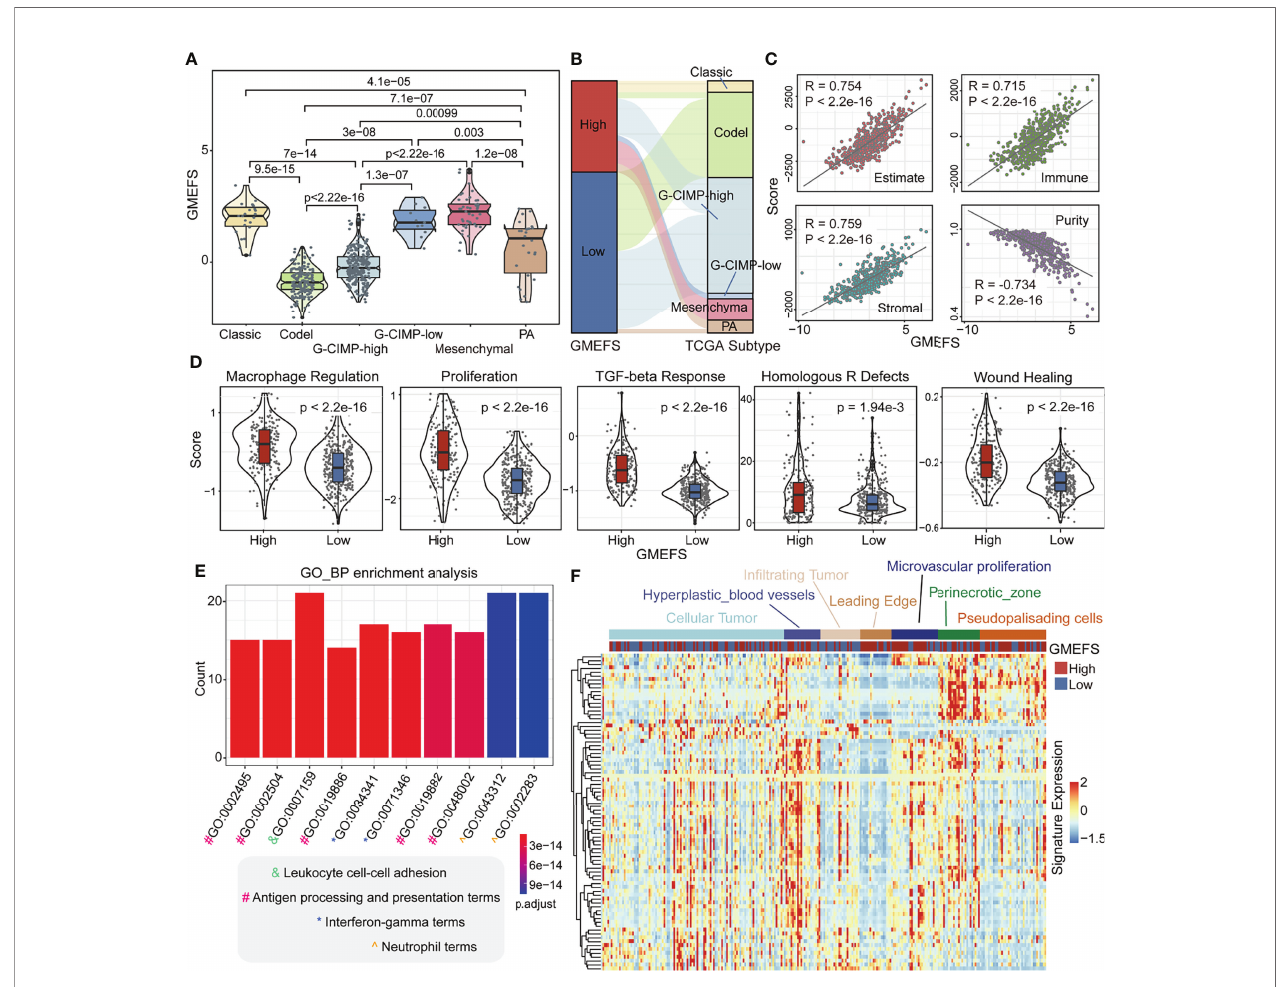
FIGURE 3 | Clinical signi fi cance and functional analysis of the two GMEFS groups in TCGA-LGG. (A) Violin plot illustrating the distribution of the GMEFS score in different intrinsic molecular subtypes. (B) Sankey plot of the GMEFS values in subtypes with different intrinsic molecular subtypes. (C) Correlations between the GMEFS score, stromal score, immune score, ESTIMATE score, and tumor purity. (D) Comparison of Macrophage Regulation, Proliferation, TGF-beta Response, Homologous R Defects, Wound Heal between the high and low GMEFS groups. TCGA-LGG patients were classi fi ed into low and high GMEFS groups. Visualization of the top 10 enriched biological processes (E) by the upregulated differentially expressed genes (DEGs) in the high vs. low GMEFS groups. (F) Heatmap of the upregulated DEGs in the Ivy Glioblastoma Atlas Project (IGAP) dataset. Samples were ordered along the row by the structure